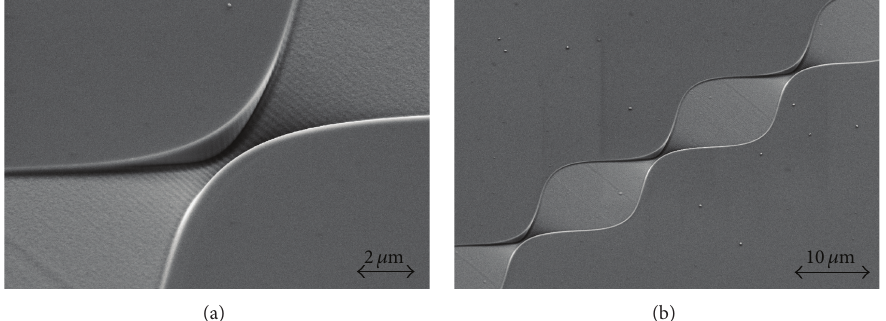
Figure 7: SEM micrographs at 45 ∘ viewing angle of a finely designed three-dimensional microfluidic mixer channel milled by using advanced dwell time control linked with the object filling algorithm applied to the pattern. Reprinted from [74]. The ability to create intricate 3D structures either by milling or deposition is perhaps the most recognized unique feature of IBL. In this example, the IBL-based fabrication of microfluidic mixer devices allows for sophisticated three-dimensional channel geometries that can be fabricated only by direct-write